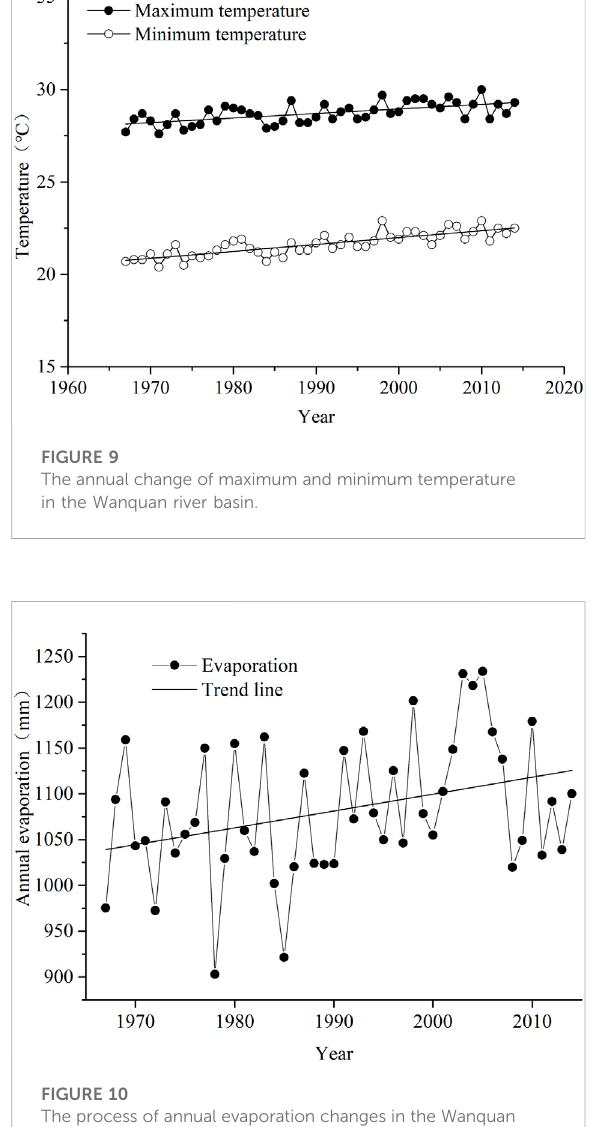
FIGURE 8 The precipitationchangesfrom 1967 to 2014 intheWanquan river basin.